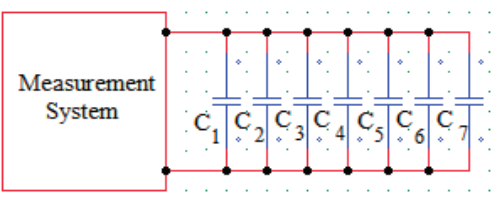
Figure 3. Measuring system of the Capacitive Sensor.